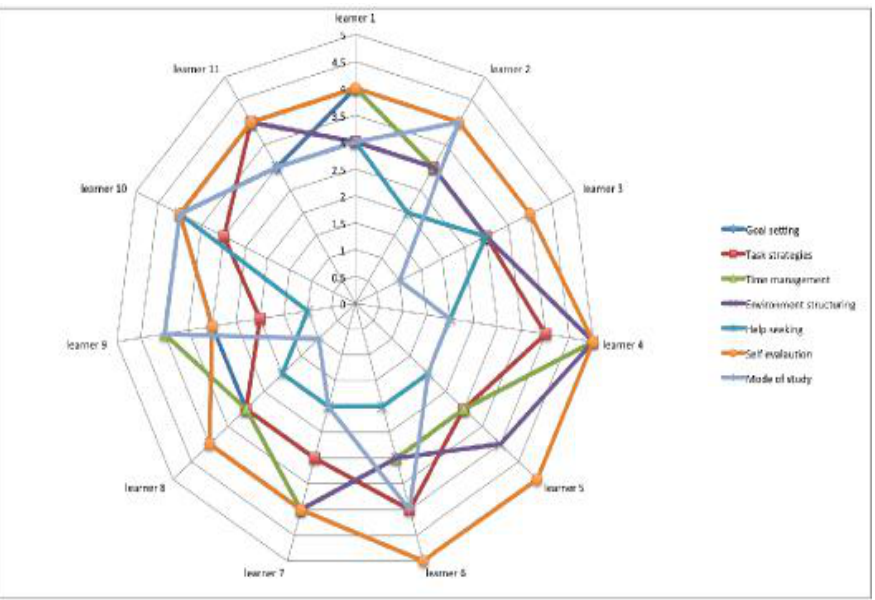
Fig. 6. Learners average SRL dimension Levels and modes of study